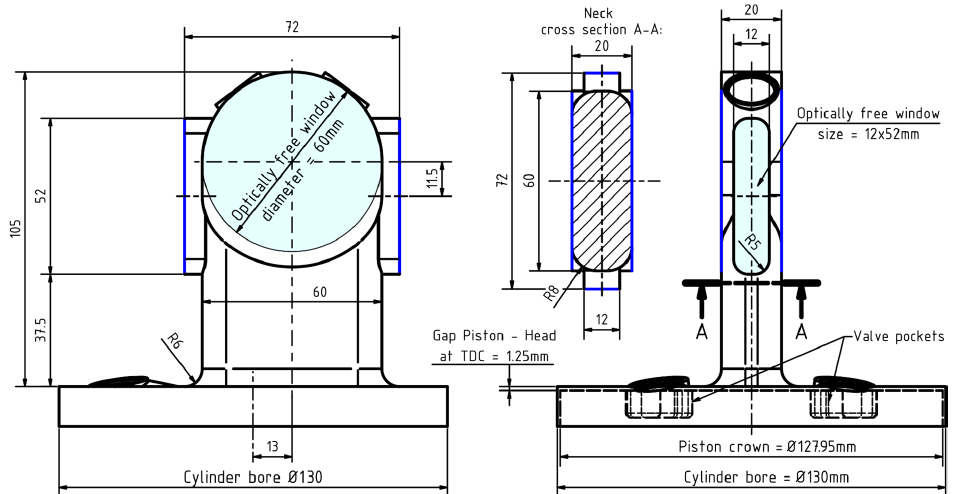
Figure 5. Dimensions of the internal volume of the optical cylinder head (at TDC piston position). For the base configuration, the total internal volume amounts to 155,600 mm 3 (compression ratio 13.8).